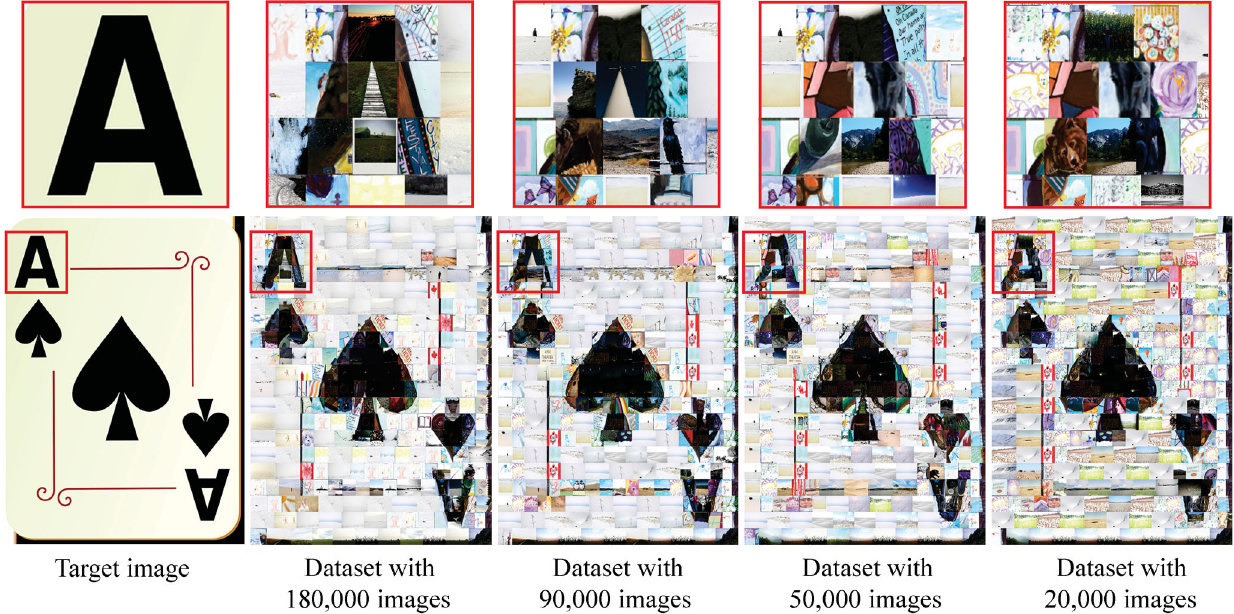
Fig. 8 Image mosaics produced by our method with different image datasets. As the size of the dataset decreases, the quality of texture matching and edge matching in the produced image mosaic degrades.